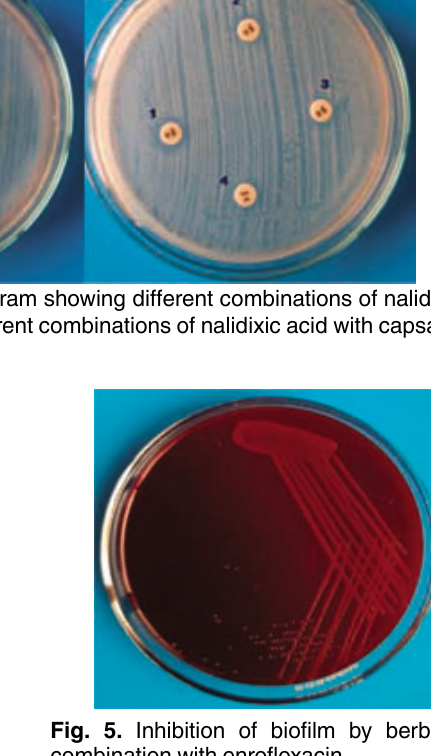
Fig. 4. Biofilm producing S. aureus